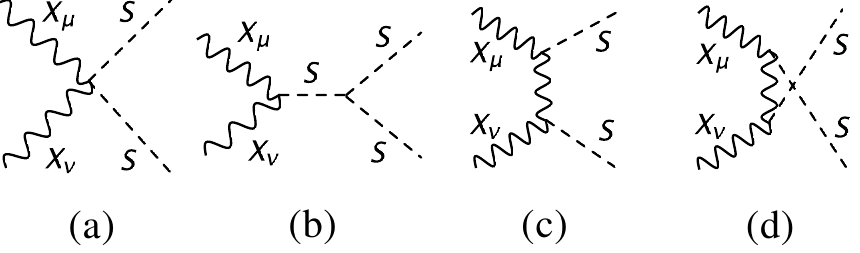
Figure 2 . Feynman diagrams that dominantly contribute to the DM annihilation cross section relevant to relic abundance and GC gamma-ray excess, where (a), (b), (c), and (d) are for the 4-vertex, s -, t -, u -channels,